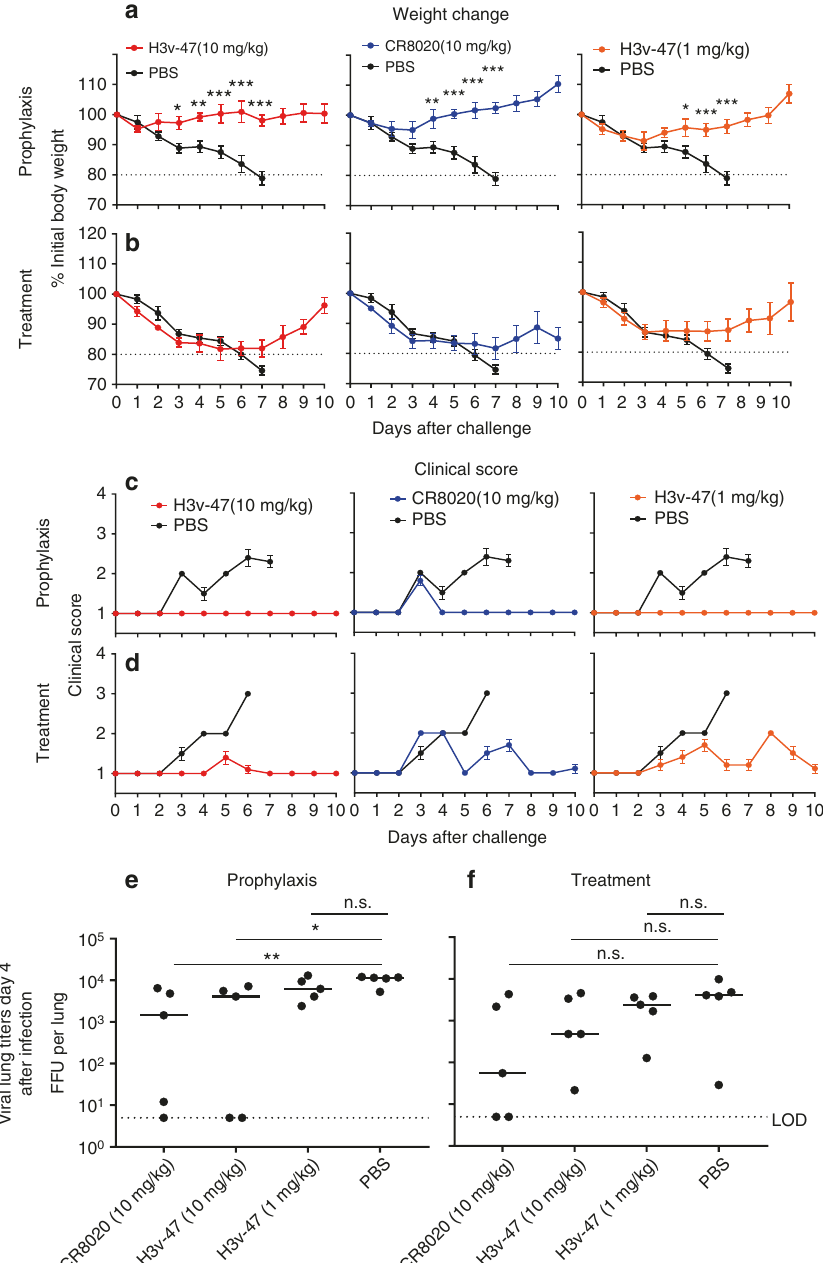
Fig. 1 Prophylactic and therapeutic ef fi cacy of mAb H3v-47 in mice. Groups of DBA/2J mice were inoculated i.p. with 10 (high dose) or 1 mg/kg (low dose) of mAb H3v-47 on the day before (day − 1, prophylaxis), or on day one (day + 1, treatment) after lethal respiratory (i.n. route) challenge with ∼ 6 × 10 4 focus forming units (FFU) of A/Minnesota/11/2010× − 203 virus and monitored for 10 days. The control groups included mice treated with PBS (mock control) or the previously described mAb CR8020. The protective ef fi cacy of mAbs was assessed by weight change kinetics ( a , b ), clinical score ( c , d ), and virus titers in lungs on 4 dpi ( e , f ). The dotted line ( a , b ) indicates the IACUC stipulated endpoint for humane euthanasia. Data in a , b shows body weight only for the animals that survived based on actual death between watches or endpoint for euthanasia, and represents the mean value ± SEM, using 10 mice per group. Each group was compared to the PBS-treated group using two-way ANOVA with Dunnett ‘ s post-hoc test for a , b , and one-way ANOVA with Dunnett ‘ s post-hoc test for e , f . Dots in e , f indicate individual mice ( n = 5 mice per group). The median titer is shown with the line, and the dotted line indicates the limit of detection (LOD). * p < 0.05; ** p < 0.01; *** p < 0.001 were considered signi fi